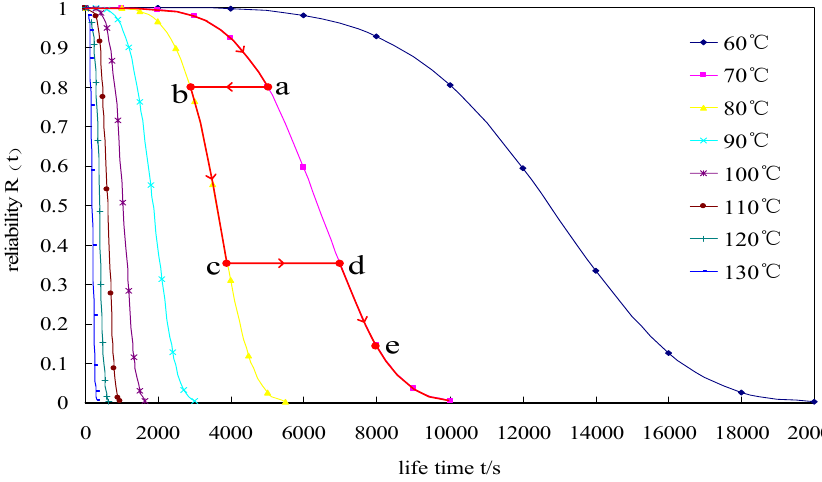
Figure 5. Test for oil–paper insulation reliability evaluation method